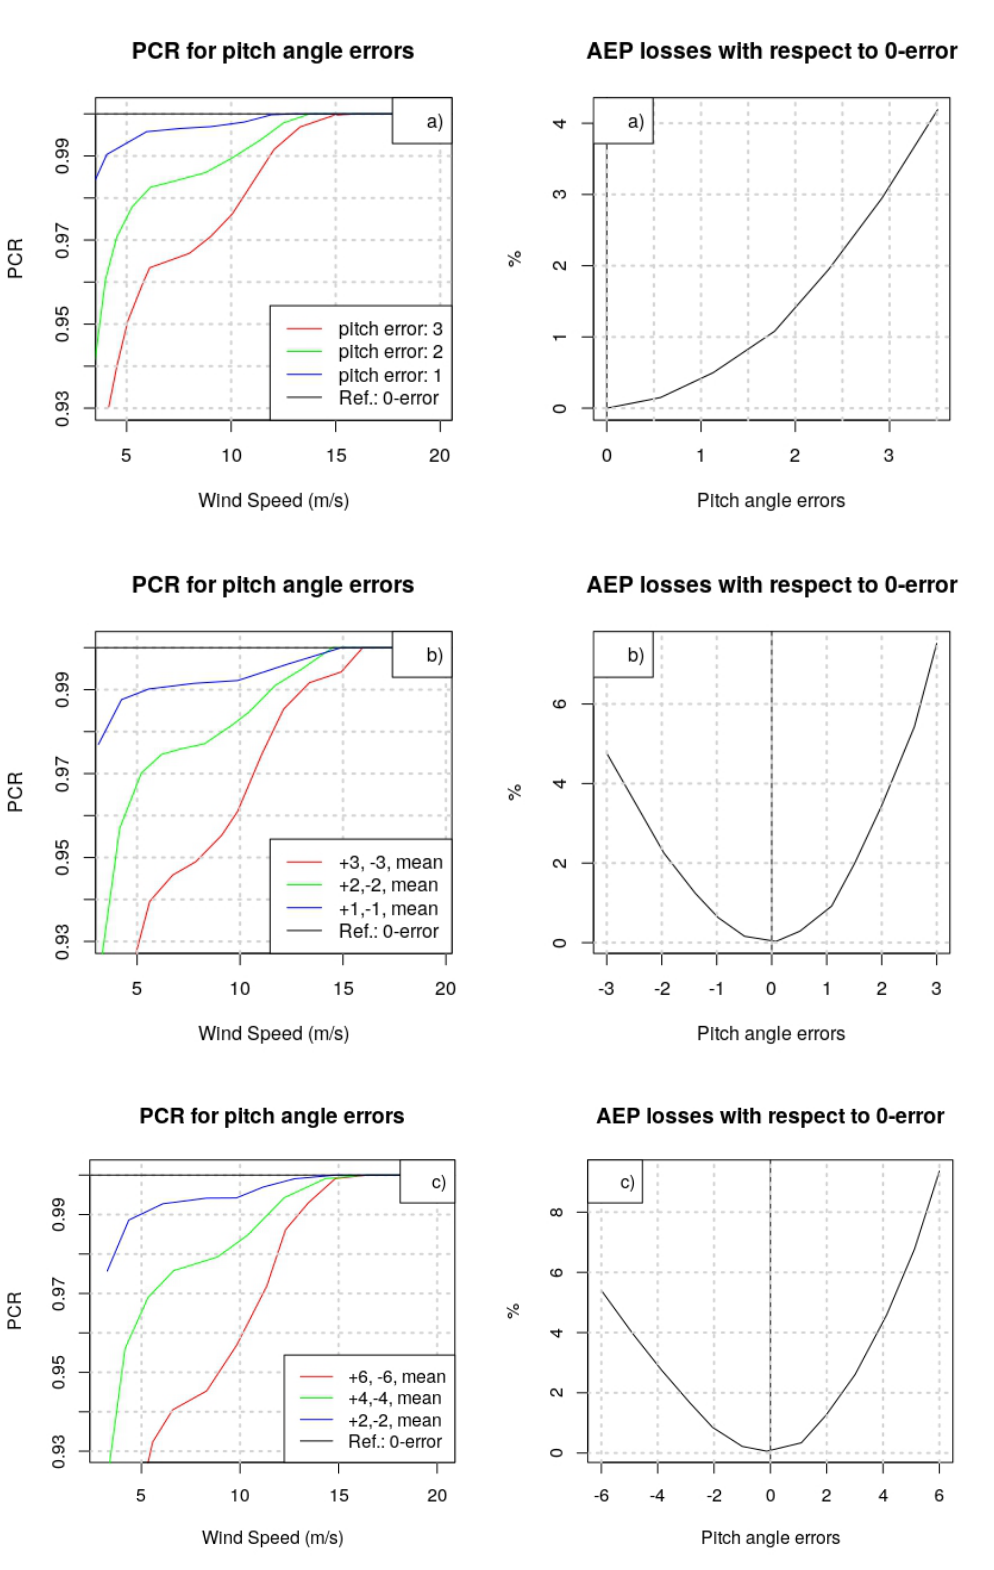
Figure 5. Dynamic FAST simulation: ( a ) Case 1; ( b ) Case 2; ( c ) Case